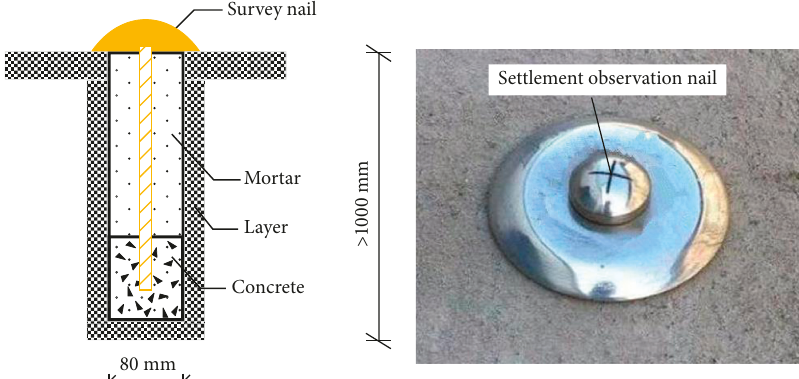
Figure 6: Buried method and physical map of surface subsidence measuring points.